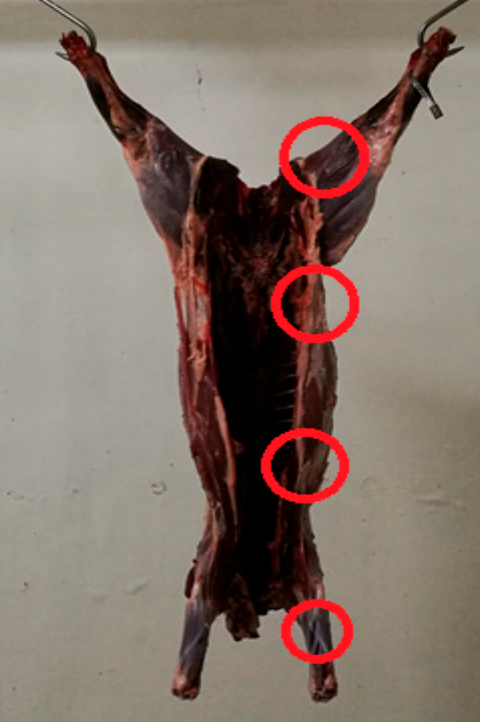
Figure 1. Sampling points on wild boar carcass selected for microbial determination.